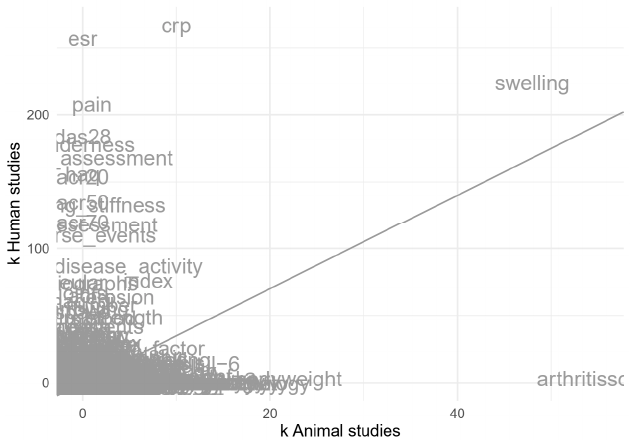
Figure 13. Impression of outcome measures in animal and human studies. For example, CRP (C-reactive protein) is reported in 10 animal (x-axis) and 267 human (y-axis) studies. The illegible part in the lower-left corner reflects a large number of rare outcomes that are not particularly relevant. The diagonal line reflects the ratio of included human vs. animal studies.